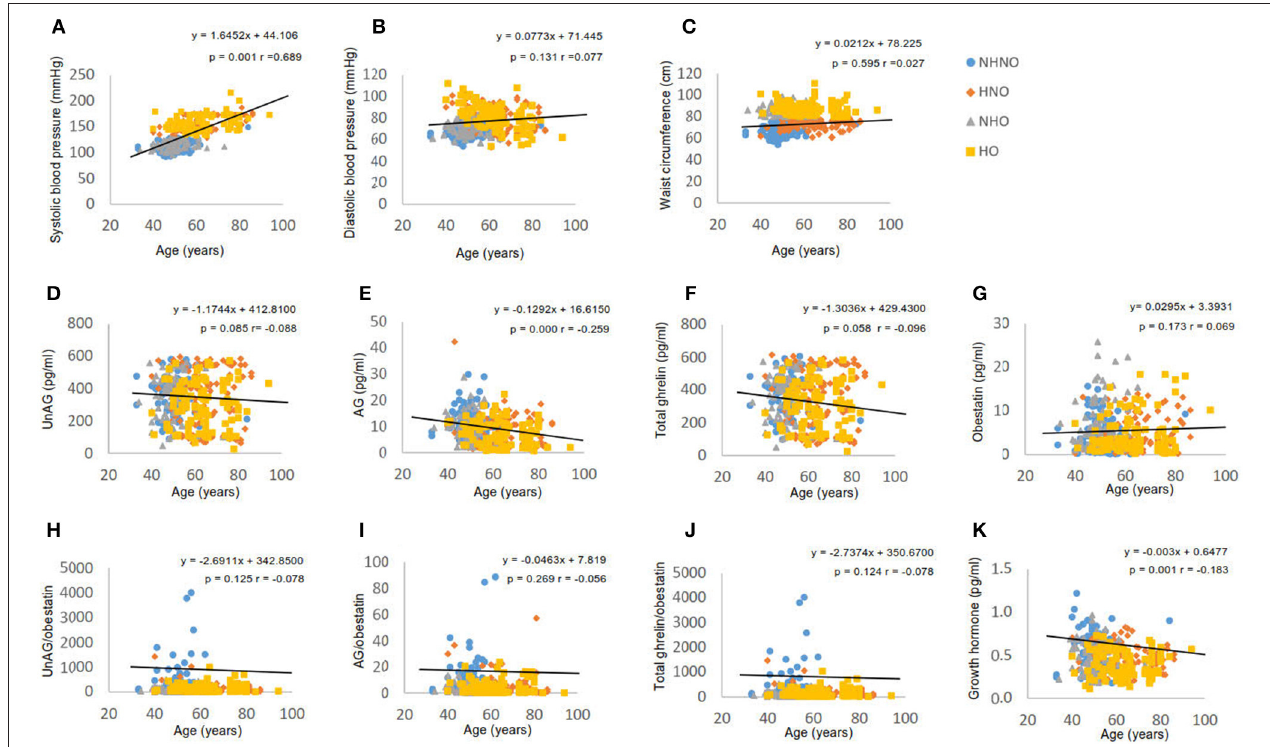
FIGURE 1 | Correlation analyses of age to waist circumference, blood pressure, ghrelin gene products, growth hormone and ratios of two forms of ghrelin to obestatin. (A) Correlation between age and systolic blood pressure. (B) Correlation between age and diastolic blood pressure. (C) Correlation between age and waist circumference. (D) Correlation between age and serum level of unacylated ghrelin. (E) Correlation between age and serum level of acylated ghrelin. (F) Correlation between age and serum level of total ghrelin. (G) Correlation between age and serum level of obestatin. (H) Correlation between age and the ratio of unacylated ghrelin to obestatin in serum. (I) Correlation between age and the ratio of acylated ghrelin to obestatin in serum. (J) Correlation between age and the ratio of total ghrelin to obestatin in serum. (K) Correlation between age and serum level of growth hormone. Pearson’s correlation analyses were performed. Statistical significance was accepted at p < 0.05. Circle refers to the data of non-hypertensive non-centrally obese subjects. Rhombus refers to the data of hypertensive non-centrally obese subjects. Triangle refers to the data of non-hypertensive centrally obese subjects. Square refers to the data of hypertensive centrally obese